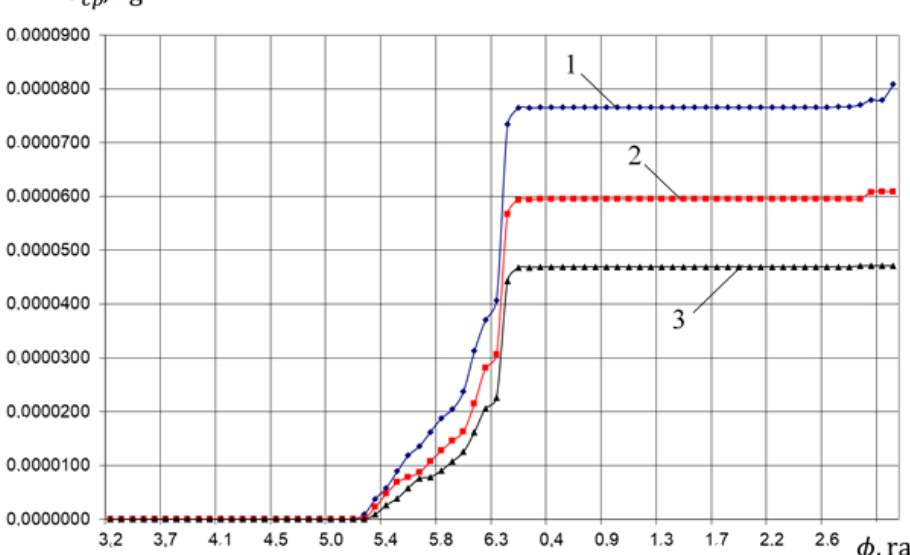
Figure 23. Dependence of the total liquid flow from the compressor section to the pump section on the angle of rotation of the crankshaft at different speeds (1— n rev = 400 rpm; 2— n rev = 500 rpm; 3— n rev = 600